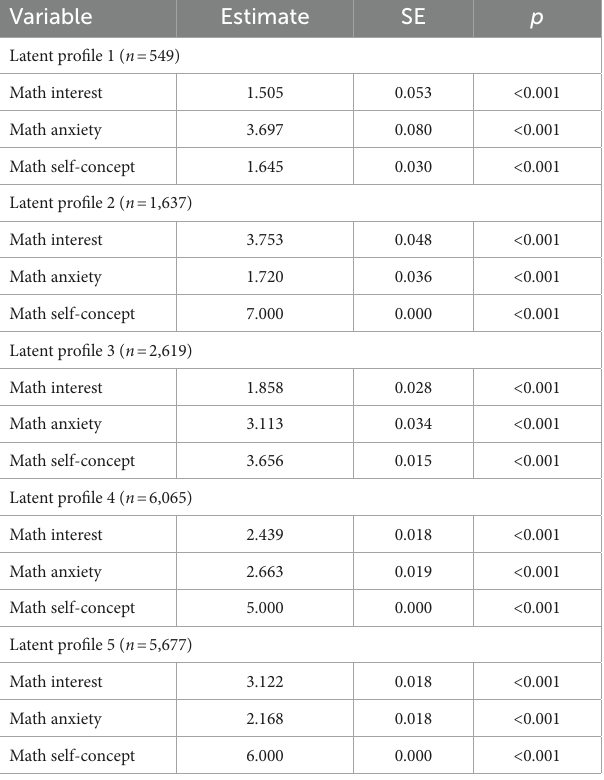
TABLE 3 Profile-specific descriptive statistics for latent profile analysis (LPA)